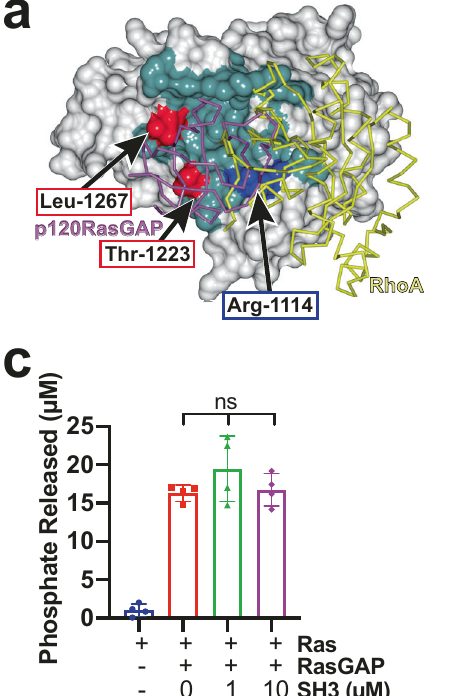
Fig. 5 | DLC1 RhoGAP mutants and p120RasGAP are not inhibited by SH3 domain. a Surface representation of DLC1 illustrating the differences in the foot- print of binding by p120RasGAP SH3 domain (purple) and RhoA (yellow, pre- dicted),withresiduesthatbindp120RasGAPcoloredteal.DLC1residuesmutatedin this study are labeled. b RhoGAP activity of structurally-de fi ned DLC1 mutants T1223D and L1267D are not inhibited by p120RasGAP SH3 domain. RhoA alone (teal) or RhoA plus the arginine fi nger mutant DLC1 R1114A (green) are included. Signal is plotted as % phosphate generated, normalized to activity of RhoA plus wild-type DLC1 (blue, 0 μ M SH3). Data are presented as mean values (bars) +/ − SD (error bars), and individual measurements are plotted (dots, n =8). P values: WT